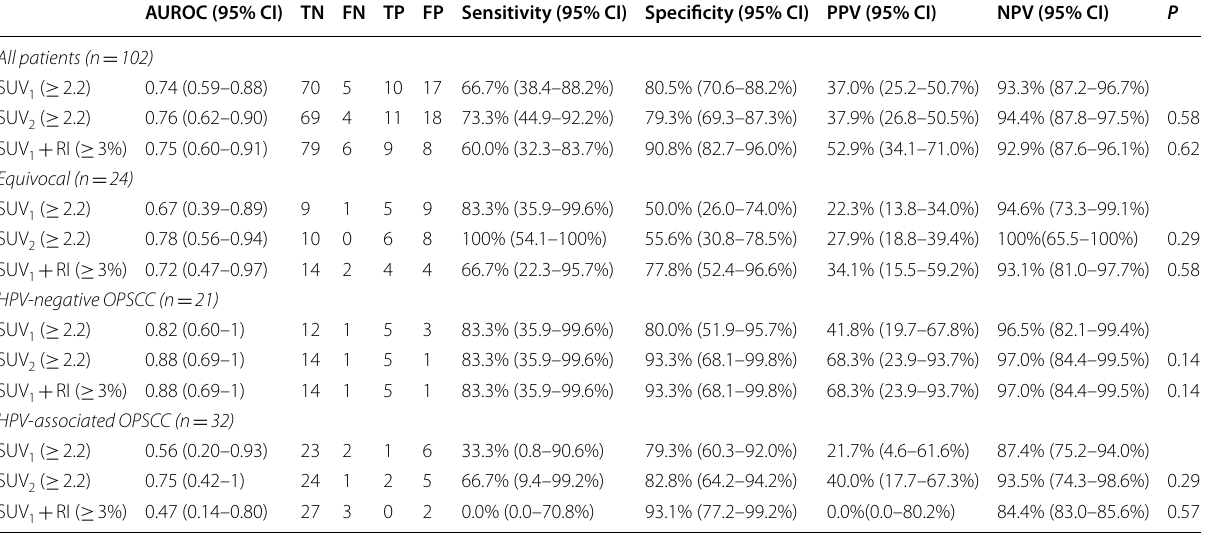
P comparison of AUROC values versus the SUV 1